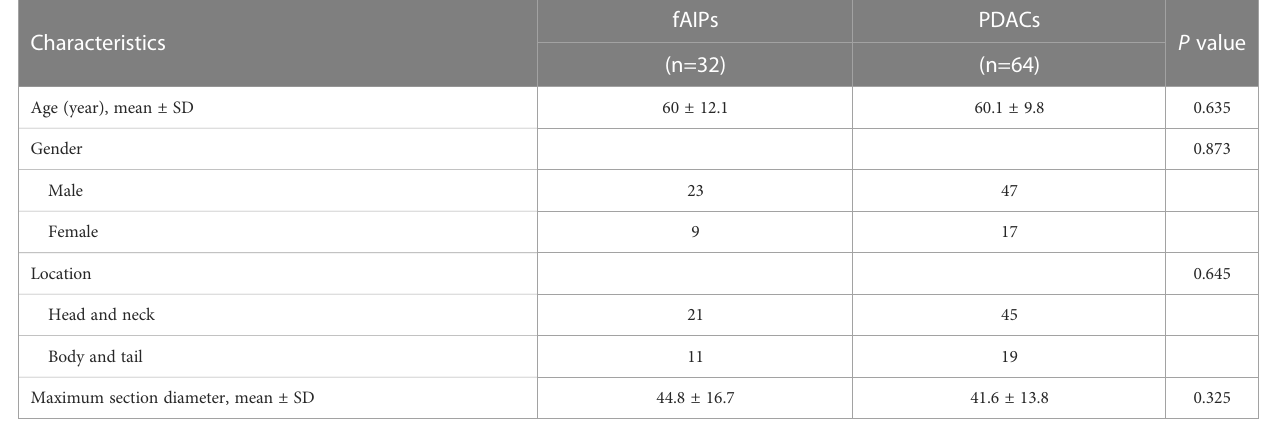
TABLE 2 Clinical characteristics of